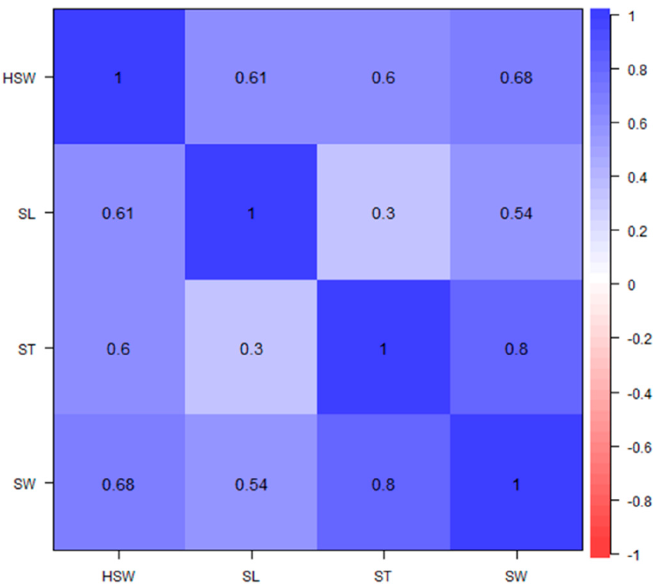
Figure 2. Phenotypic correlation coefficient of seed size traits of 196 accessions of African yam bean evaluated during the 2018 and 2019 cropping seasons at three locations in Nigeria: HSW, 100-seed weight; SL, seed length; SW, seed width; ST, seed thickness.